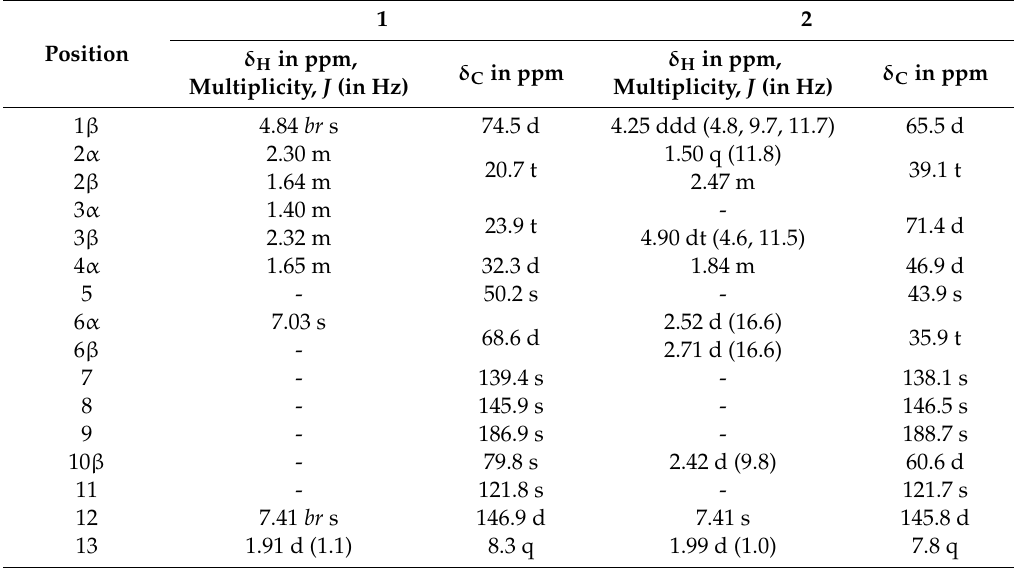
Table 1. 1 H (500 MHz) and 13 C (125 MHz) NMR data of compounds 1 and 2 in CDCl 3 .